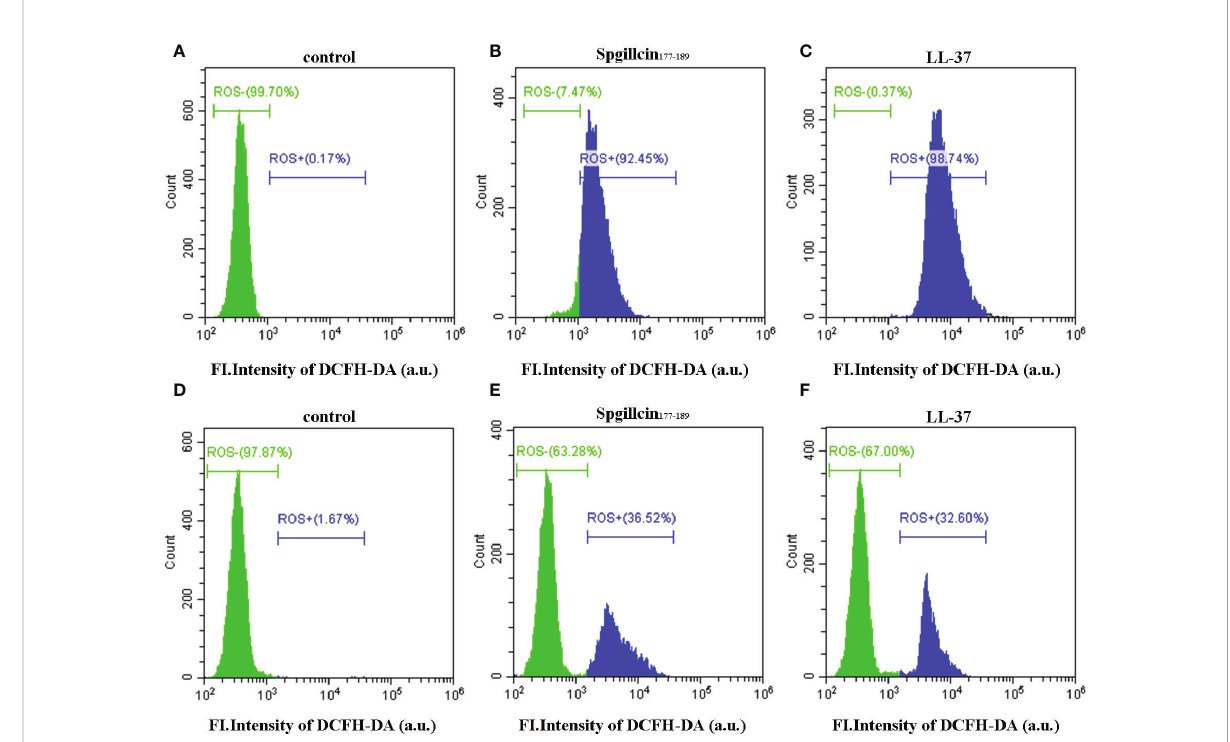
FIGURE 9 Detection of intracellular reactive oxygen species levels. Fluorescence intensity of DCFH-DA probe on S. aureus treated with NaPB (A) , Spgillcin 177 – 189 (B) , or LL-37 (C) . Fluorescence intensity of DCFH-DA probe on P. aeruginosa treated with NaPB (D) , Spgillcin 177 – 189 (E) , or LL-37 (F)